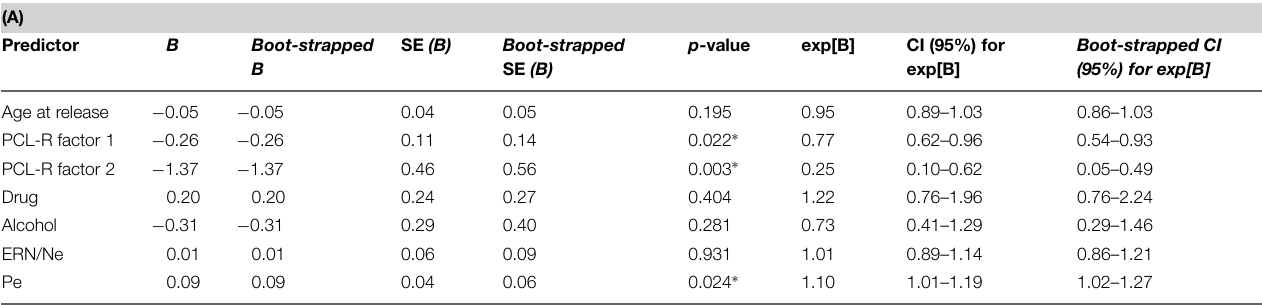
TABLE 4 | Cox regression combining ERP or fMRI measures with covariates predicting rearrest ( N =